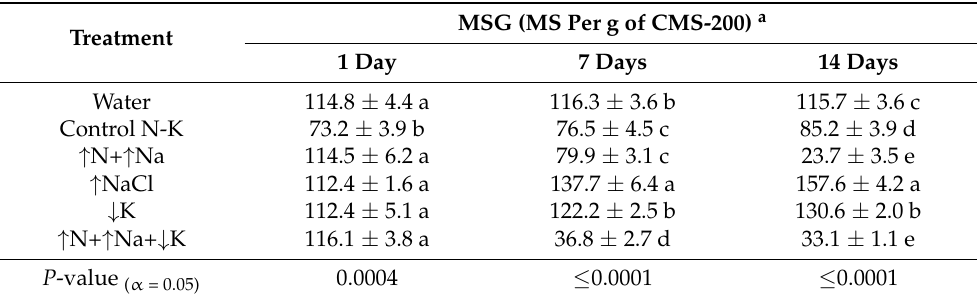
Table 2. Effects of treatments on microsclerotia (MS) viability of V. dahliae isolate V323 for each exposure period (1, 7 and 14 days)